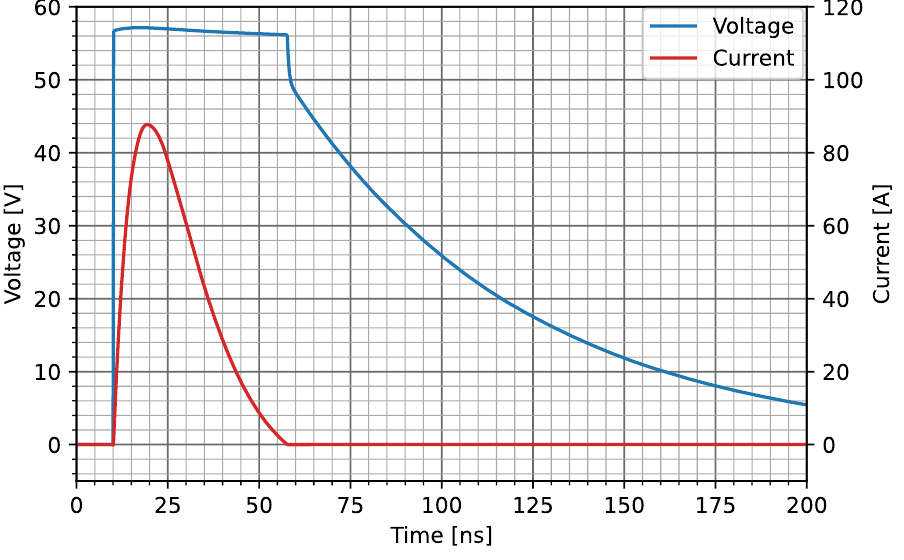
Figure 33. LTspice simulated voltage and current plots for a large transient stimulus applied in the re- verse